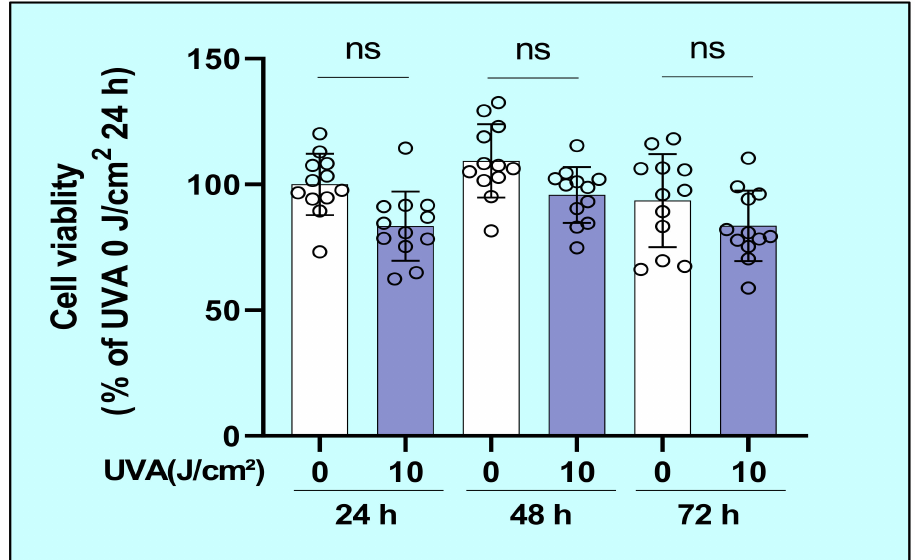
Figure 1. Effects of UVA on the viability of human dermal fibroblasts (HDFs) in culture. HDFs were cultured for 72 h following UVA irradiation at the indicated dose and their viability was evaluated using the MTT assay at the indicated time post-irradiation. Data represent means ± SD. n =